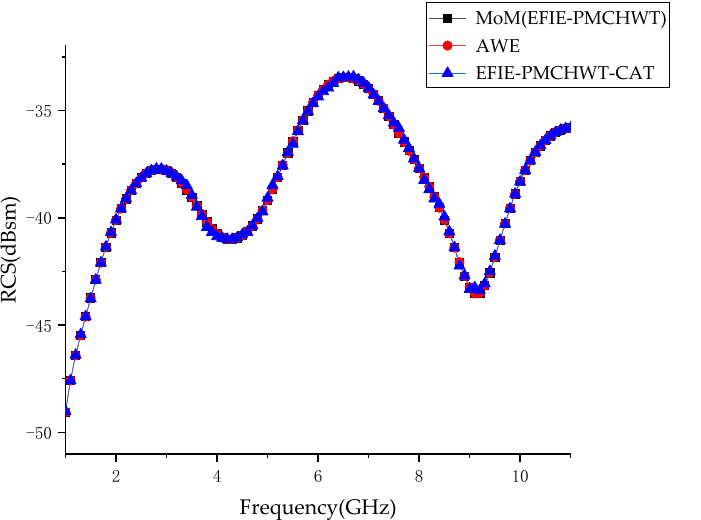
Figure 16. RCS frequency response of the coated missile of the MoM (EFIE-PMCHWT), AWE, and EFIE-PMCHWT-CAT.